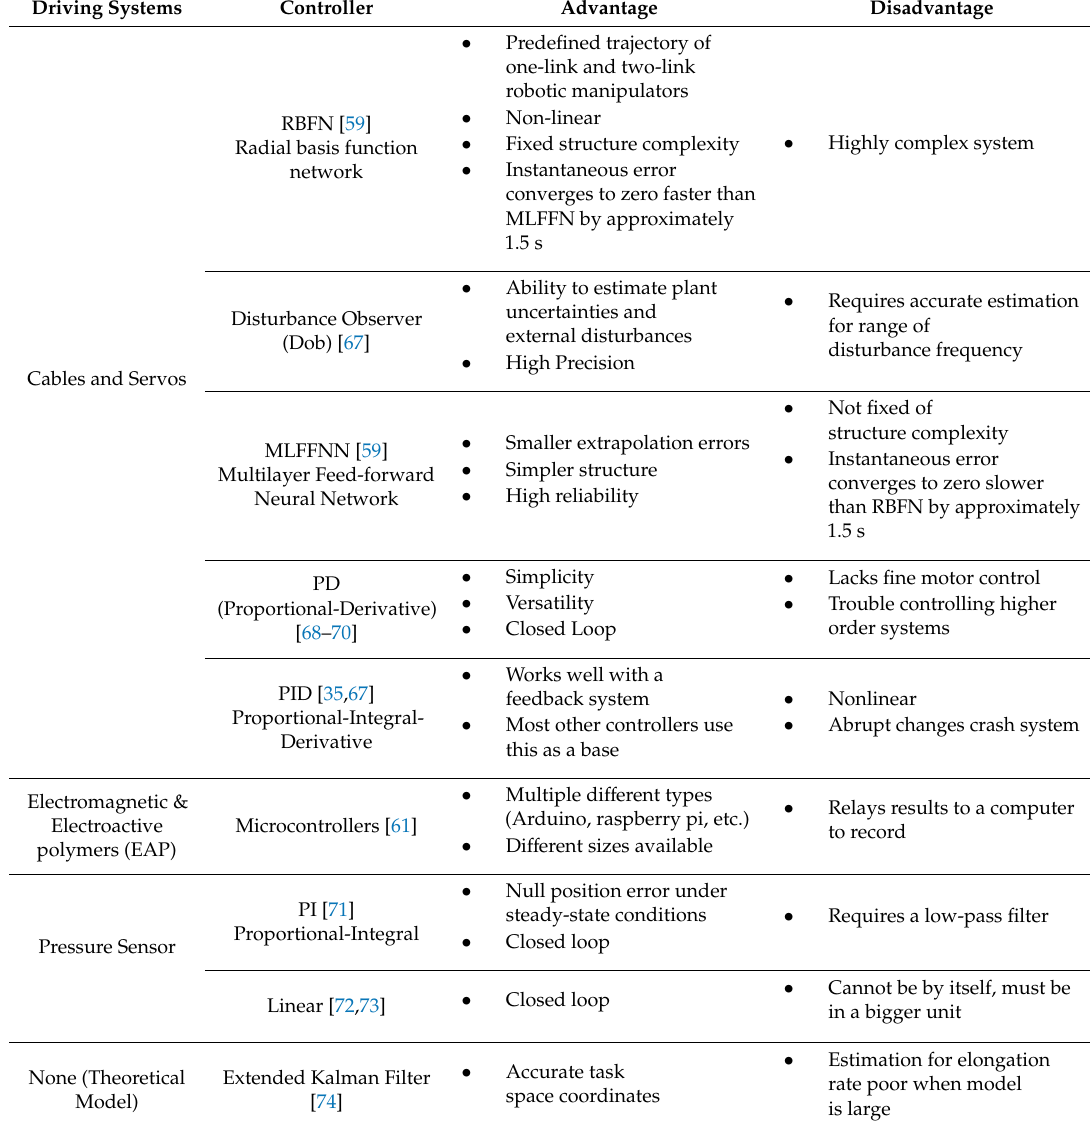
Table 1. Comparison of di ff erent control